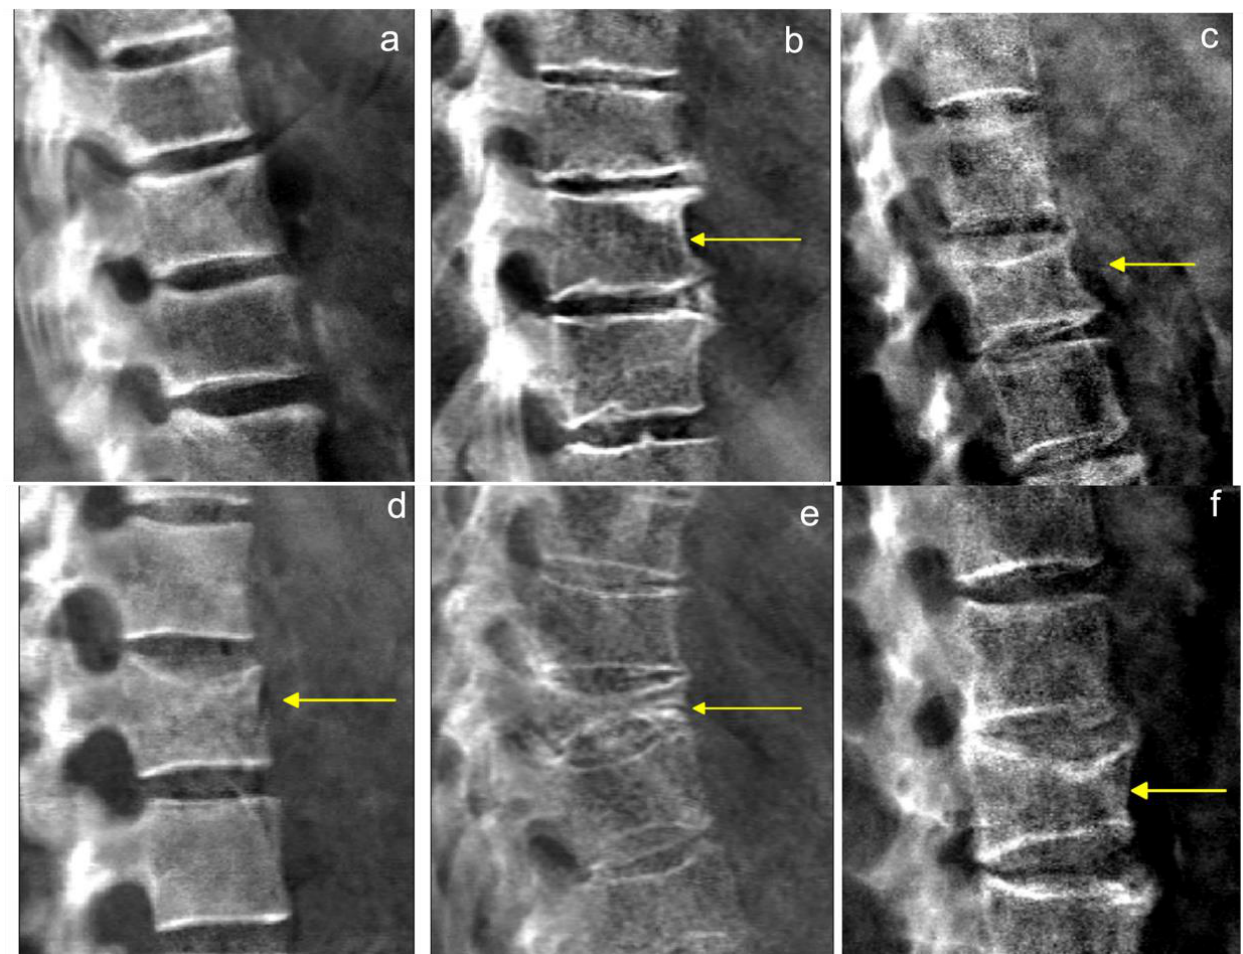
Figure 3. Selected lateral spine dual energy X-ray absorptiometry scans from a series of patients demonstrate the semiquantitative visual grading system of Genant et al. [16]: ( a ) normal vertebrae, ( b ) deformed vertebrae (spondylosis), ( c ) grade 1 (mild fracture, 20–25% reduction of vertebral height), ( d ) grade 2 (moderate fracture, 25–40% reduction of vertebral height), ( e ) grade 3 ( severe fracture, >40% reduction of vertebral height), and ( f ) vertebra where beginner radiographer misdiagnosed (giving grade 2 instead of